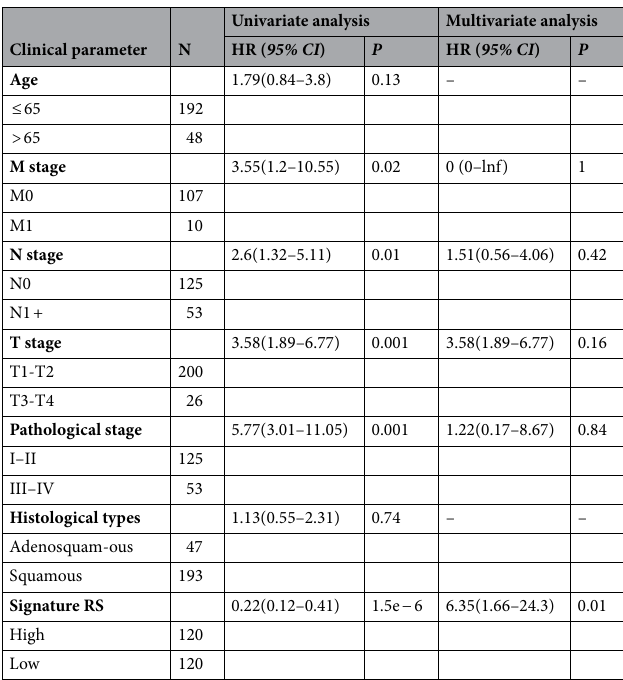
Table 2. Univariate and multivariate Cox regression analysis of characteristics and Signature RS in CESC. N number of patients, HR hazard ratio, CI confidence interval, RS risk score, P P value